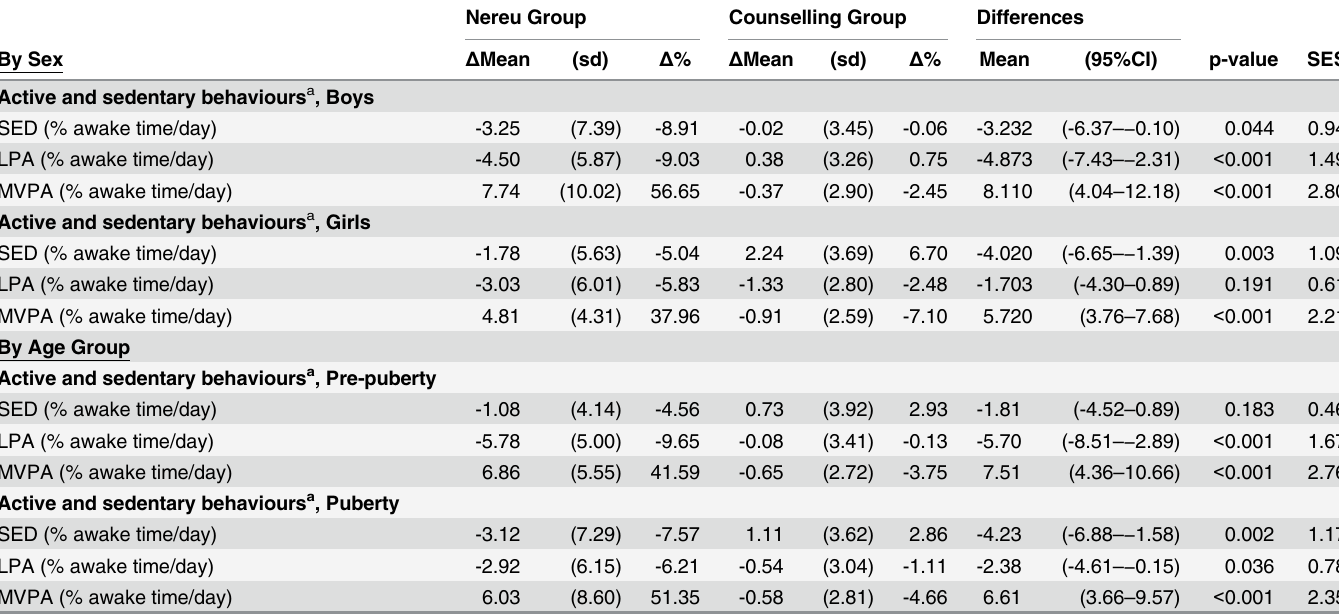
Table 3. Differences in Outcomes Between Nereu Program (NP) and Counselling Group (CG) by Sex and Age. Nereu Group Counselling Group Differences